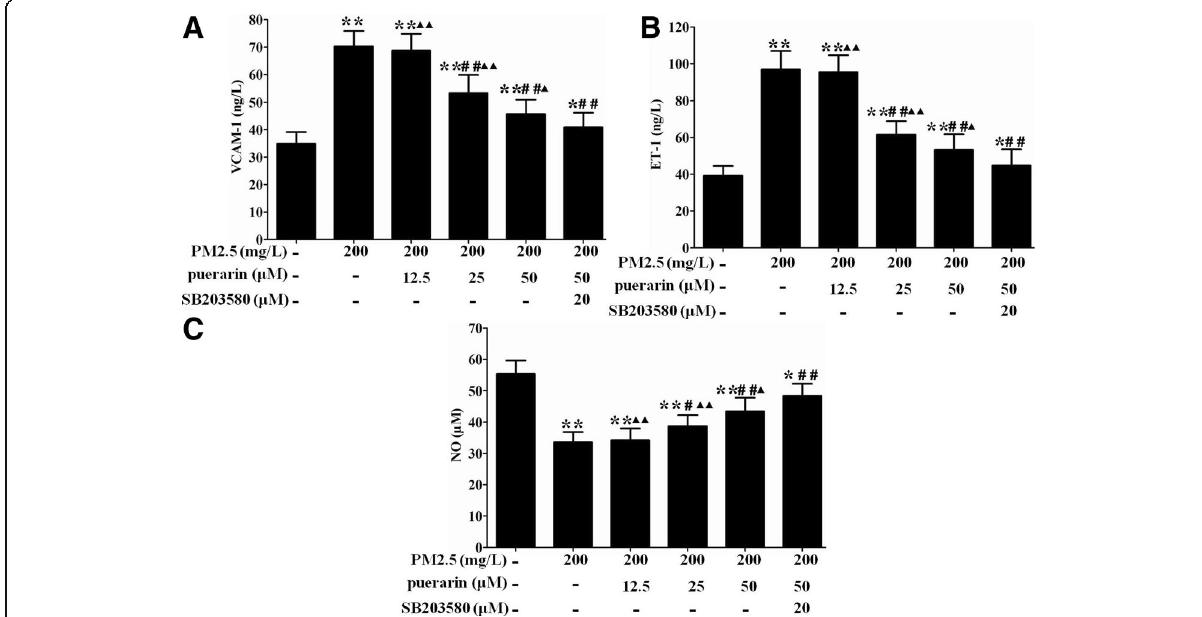
Fig. 4 Effect of puerarin on the levels of VCAM-1, NO and ET-1 in VSMCs. Cells were pre-treated with puerarin at different concentrations (0, 12.5, 25, 50 μ M) or p38 MAPK inhibitor SB203580 (20 μ M) for 1 h and followed by the addition of 200 mg/L PM2.5 for 24 h. a VCAM-1 level was measured by ELISA. b ET-1 level was determined by radioimmunoassay. c No level was evaluated by nitrate reductase method. The results are presented as mean ±SEM. n =3. Compared to the untreated cells, * P <0.05, ** P <0.01; compared to 200 mg/L PM2.5 group, # P < 0.05, ## P < 0.01; compared to the